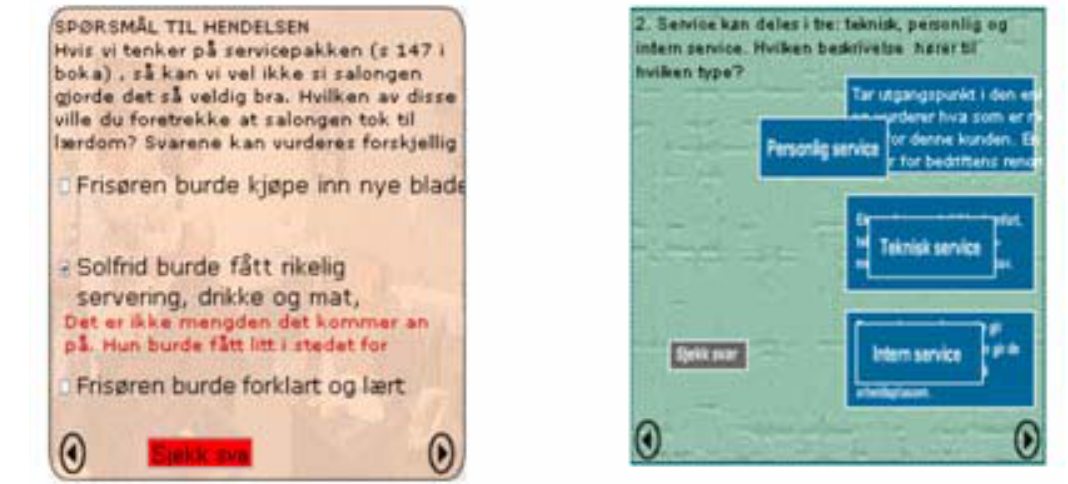
Figure 4. Screen shots from the PDA of multi-media multiple-choice question and 'drag-and- drop'